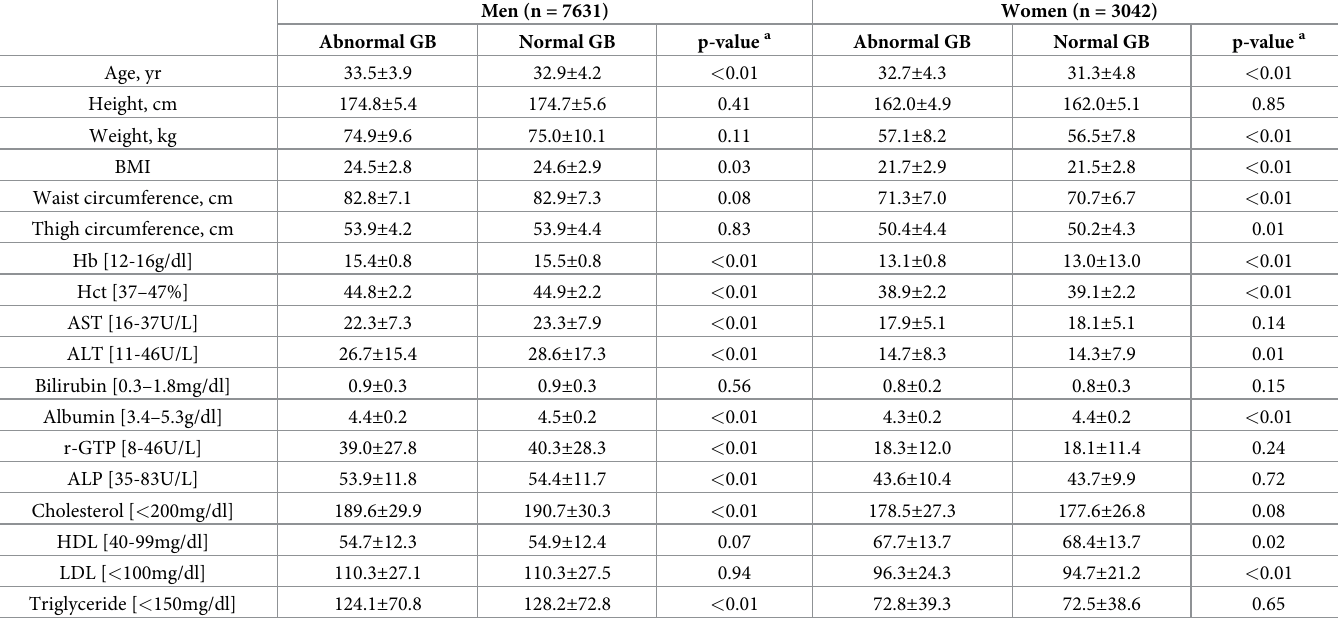
Table 3. Anthropometric indices and laboratory data of the young age group with abnormal GB finding (stones, sludge, polyps, and adenomyomatosis) and normal GB